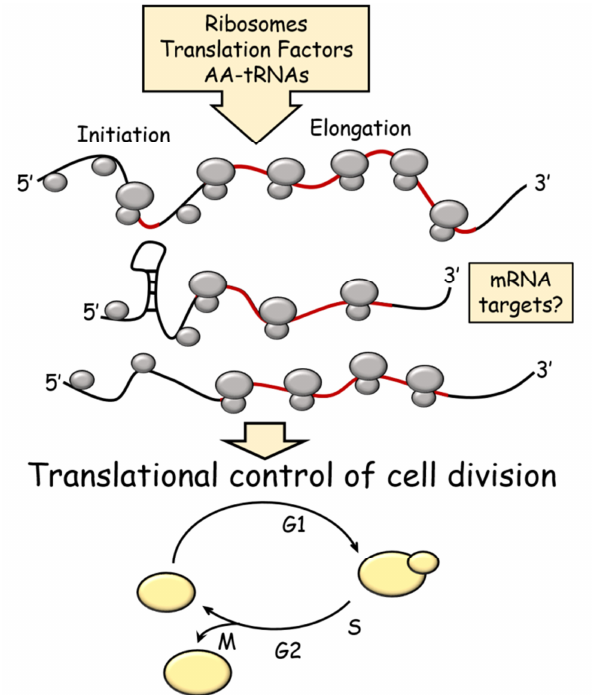
FIGURE 1: Schematic overview of the topics covered in this review. Open reading frames (ORFs) are shown in